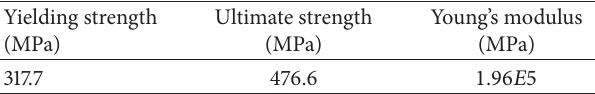
Table 1: Experimental mechanical properties of steel